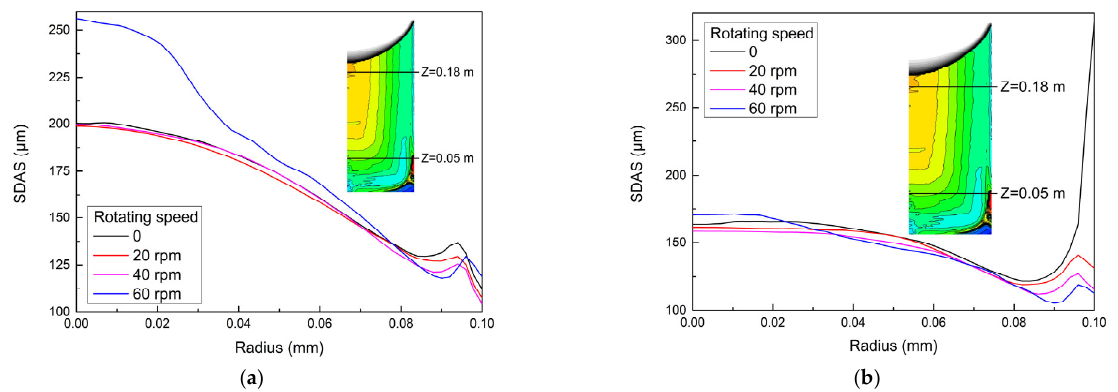
Figure 11. Predicted radial distribution of SDAS at different horizontal sections: ( a ) Z = 0.18 m; ( b ) Z = 0.05 m.